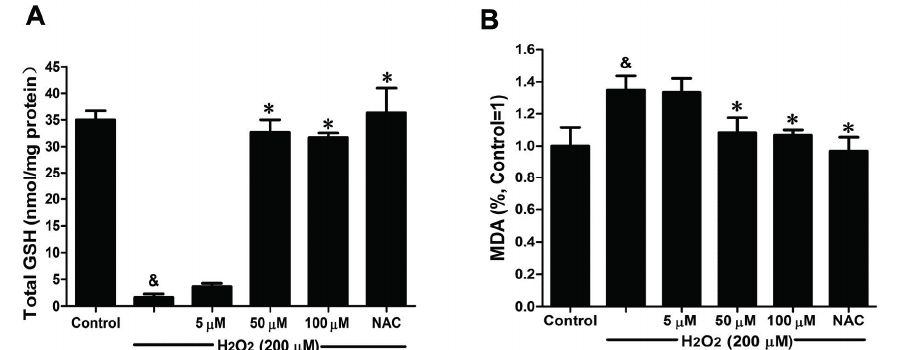
Figure 6. DSC improved anti-oxidative capacity in H 2 O 2 -stimulated HUVEC. HUVEC were incubated with indicated concentrations of DSC or NAC for 4 h, then stimulated with H 2 O 2 (200 μ M) for 12 h; the GSH activity ( A ) and MDA ( B ) production were measured, respectively. Data shown are means ± SEM, & p < 0.05 compared with unstimulated cells, * p < 0.05 compared with H 2 O 2 -stimulated cells. Data were from at least three independent experiments, each performed in